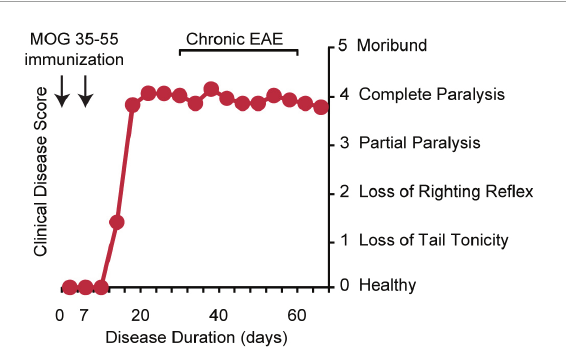
FIGURE1 Chronic EAE disease induction and clinical disease